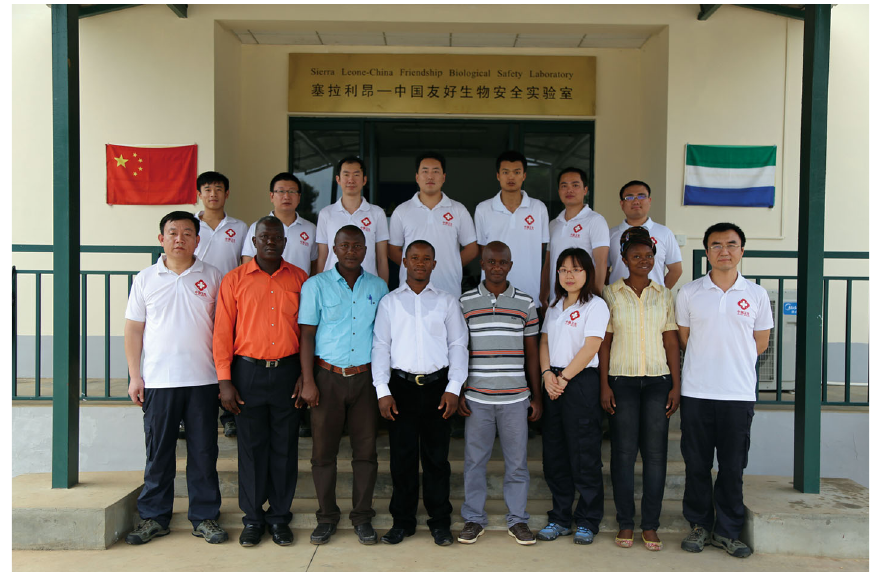
Figure 5. The fourth Ebola test team from China working in the fi xed P3 lab together with their Sierra Leonian